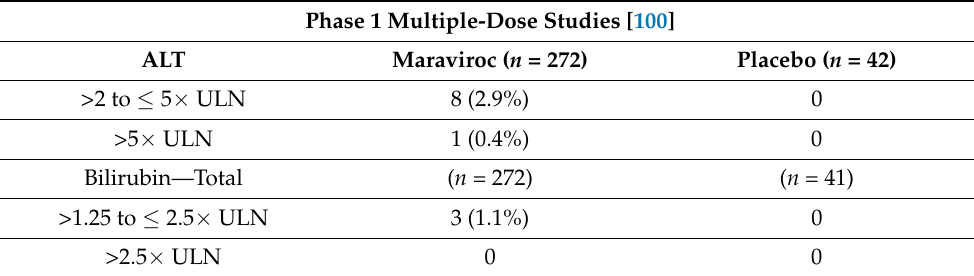
Table 6. ALT and bilirubin abnormalities noted in maraviroc phase 1 multiple-dose studies. Phase 1 Multiple-Dose Studies